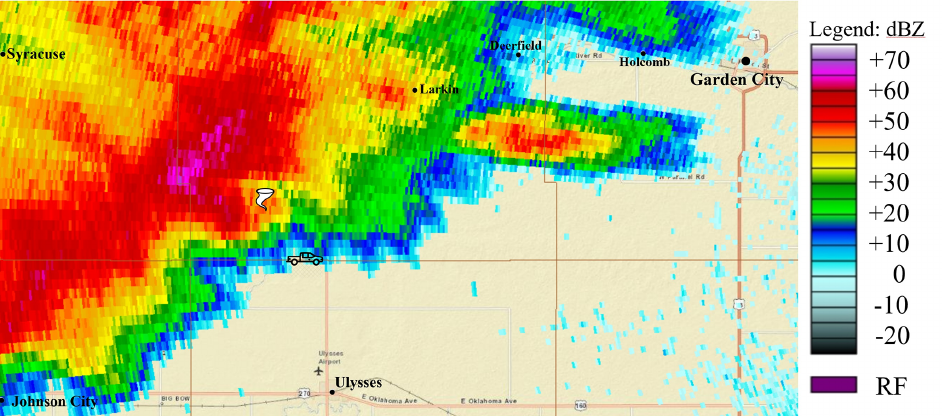
Figure B1. KDDC (Dodge City Regional Airport, KS) reflectivity measurement at 22 May 2020, 00:17UTC, with elevation of the scan = 2590ft (790m) (lowest possible base scan). The tornado location is indicated via the tornado icon and the storm-chaser region of intercept via the truck icon.